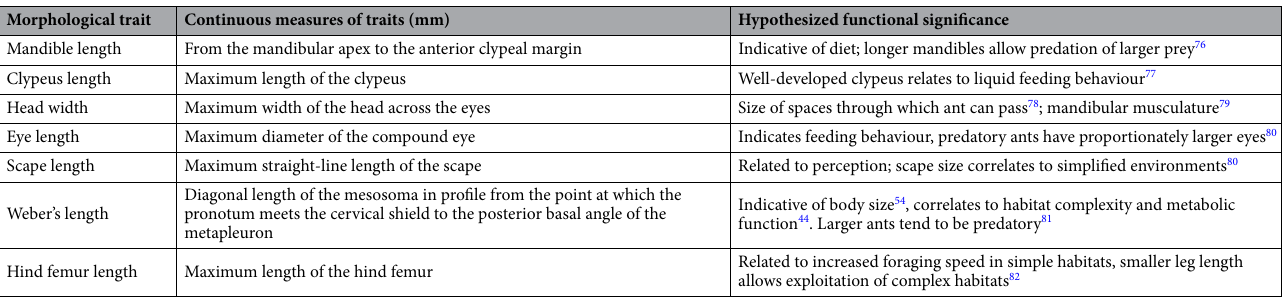
Table 1. Ant morphological traits that were measured and used to assess functional diversity of ant assemblages, and their functional